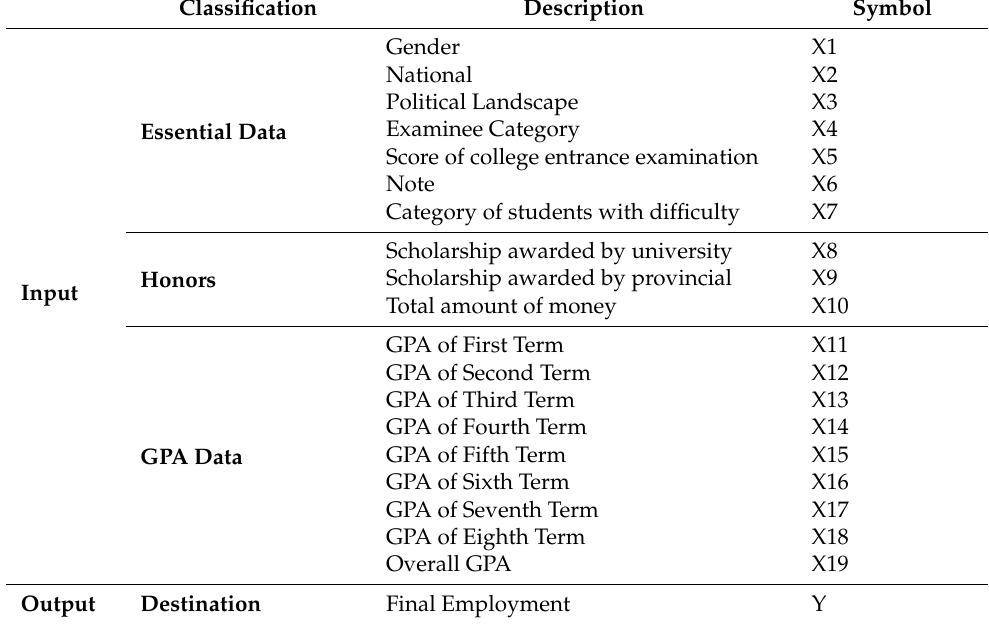
Table 1. Dataset description.